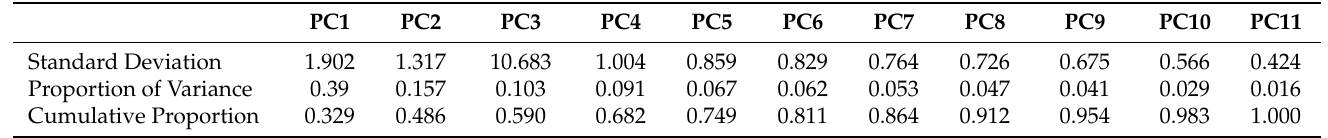
Table 7. Principal component analysis (Intrinsic value, variance ratio, cumulated variance) for the variables color and mineral composition of honeys produced in Chile’s central-southern